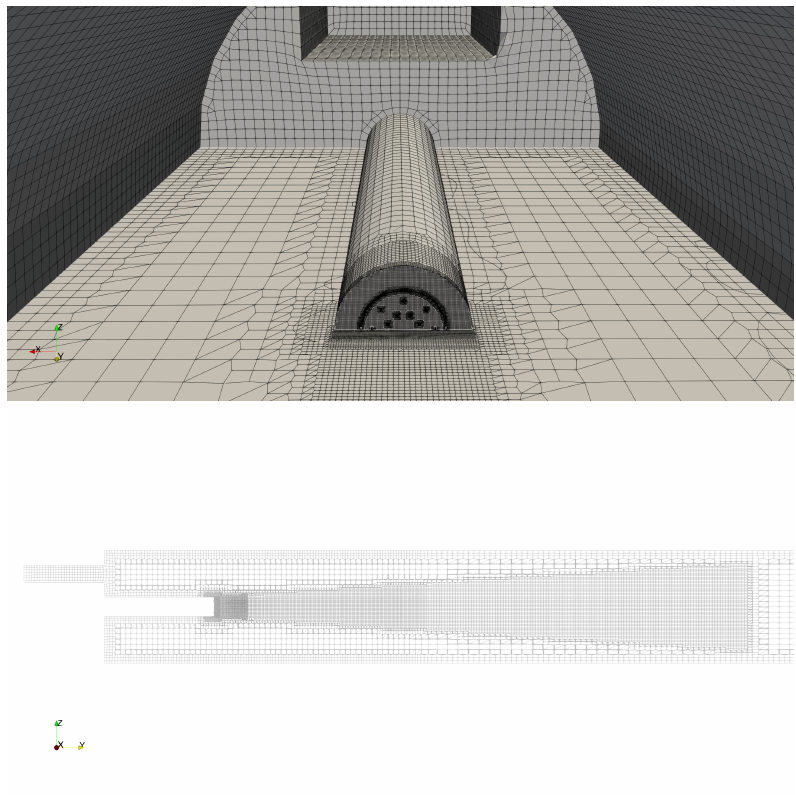
Figure 1. Mesh in the vicinity of the hot end of the kiln ( top ) and along the center axial section ( xz -plane at y = 0) ( bottom ). In the top figure, the burner pipe, the burner and the secondary air inlet can be seen, The mesh is locally refined around the burner, the burner outlet and at the exterior